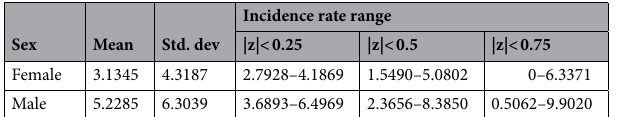
Table 4. ALS incidence rate ranges for determining reference counties in Ohio, as defined by the